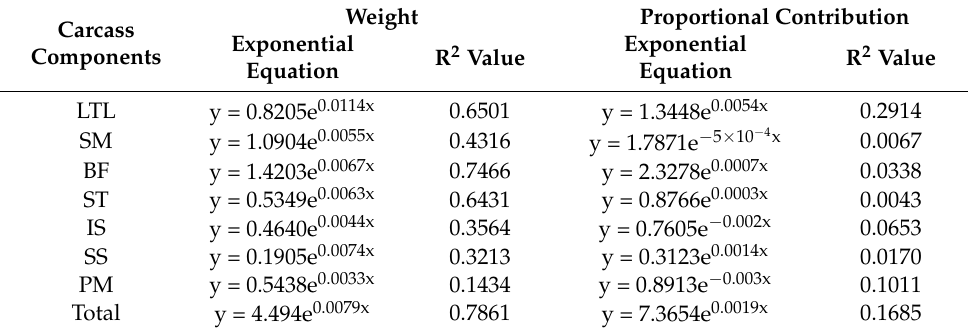
Proportional Contribution